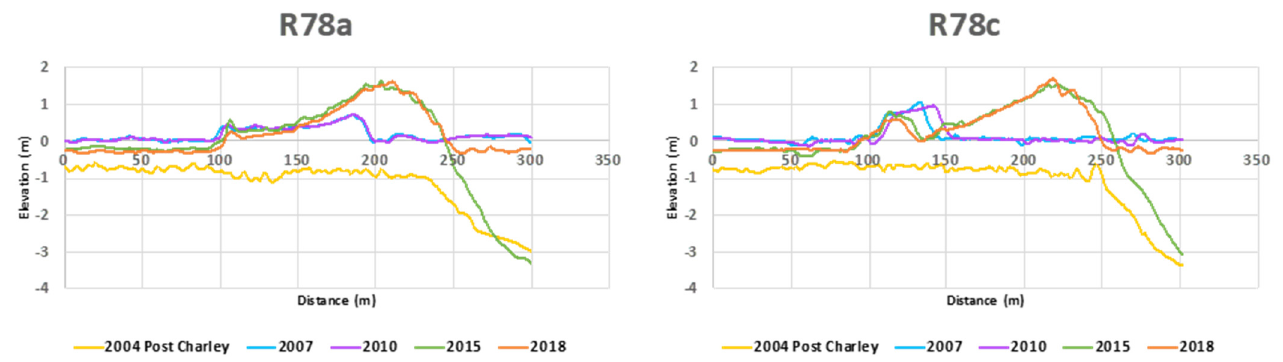
Figure 5. R78a and R78c elevation profiles with respect to NAVD88 of North Captiva Island for 2004 post-Charley .